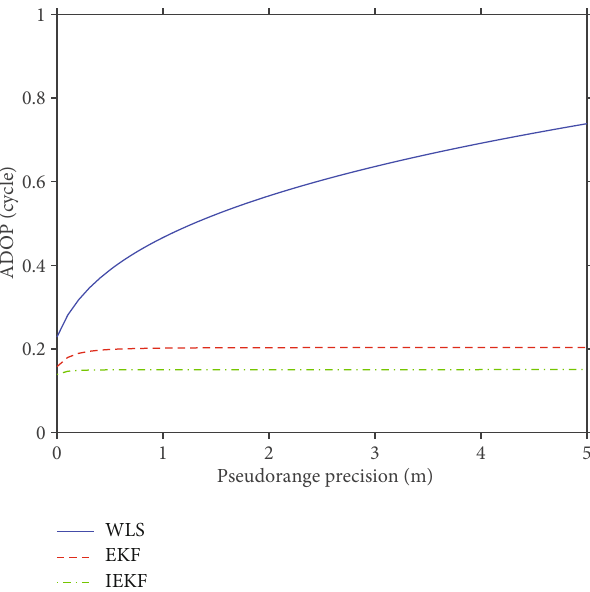
Figure 5: The ratio values of various algorithms (Data